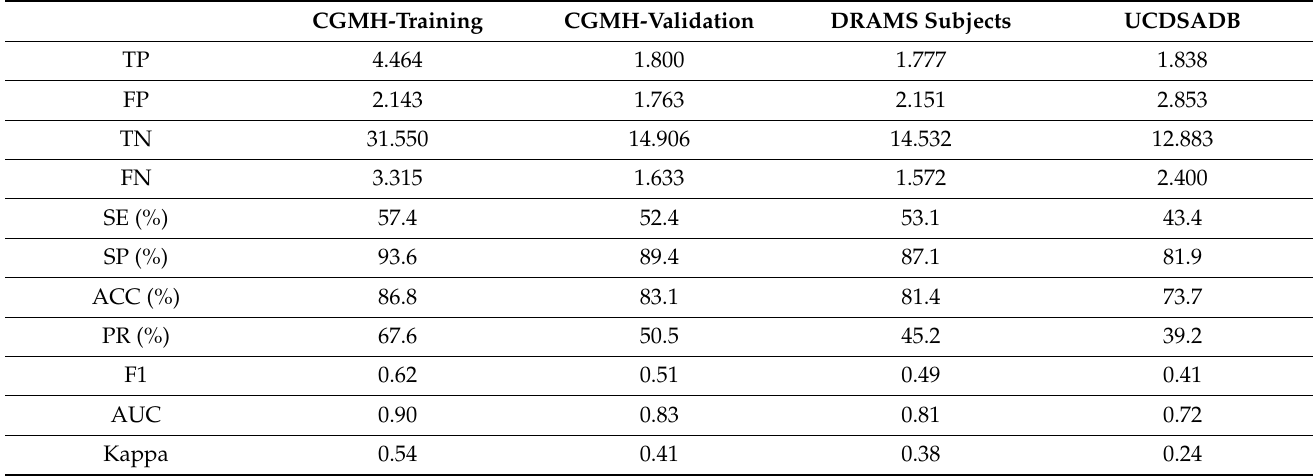
Table 3. CNN model performance in distinguishing between wake and sleep stages, measured